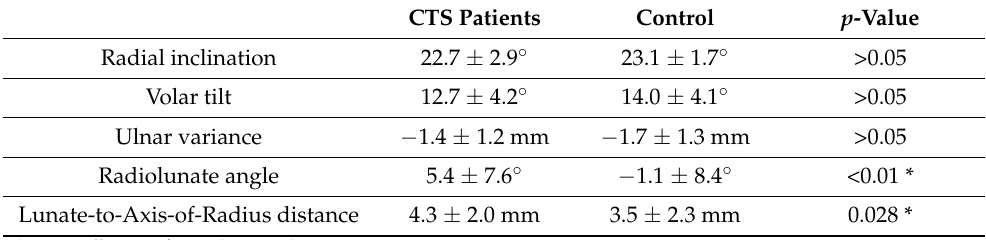
Table 2. Results of radiological parameters of each group.